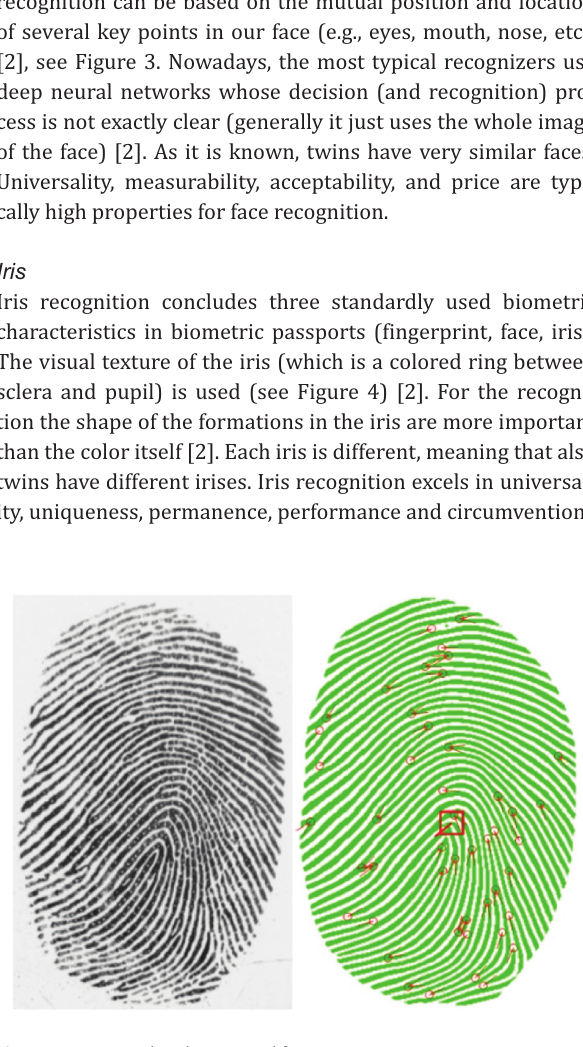
Figure 2 Acquired and processed fingerprint